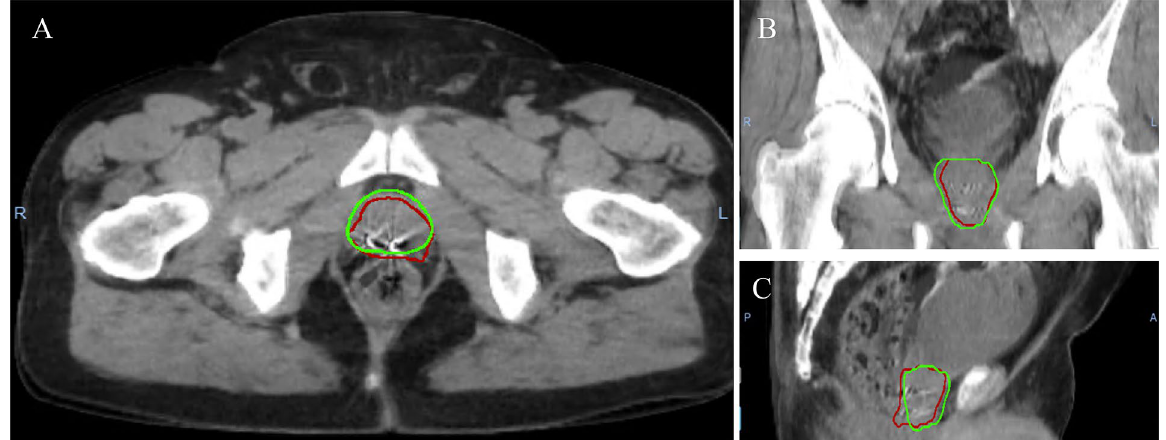
Figure 4. Automatically generated prostate contour (red) and manually drawn contour (green) for sample patient with poor match statistics (DSC<0.8 and MDA>3). Shown axial slice ( A ), coronal slice ( B ), and sagittal slice ( C